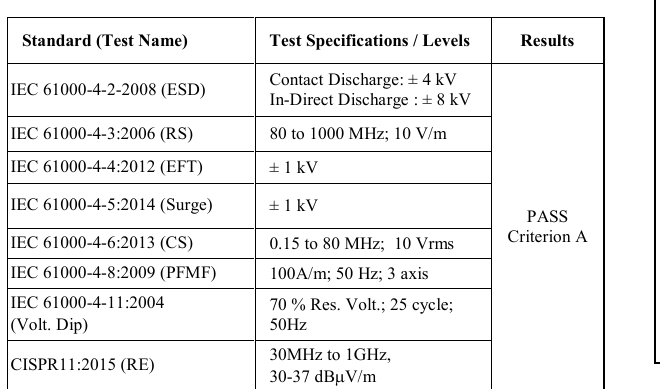
Fig. 12: Prototype Centralized Interlock and Protection Module (CIM)